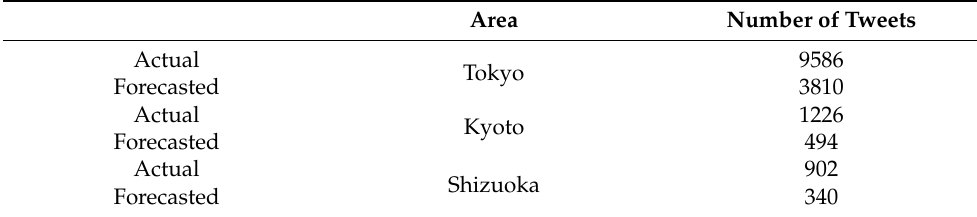
Figure 7. Shizuoka after forecasting in 2019 (proposed method (1)). Table 1. Number of tweets, actual total, and the forecasted total (proposed method (1)).